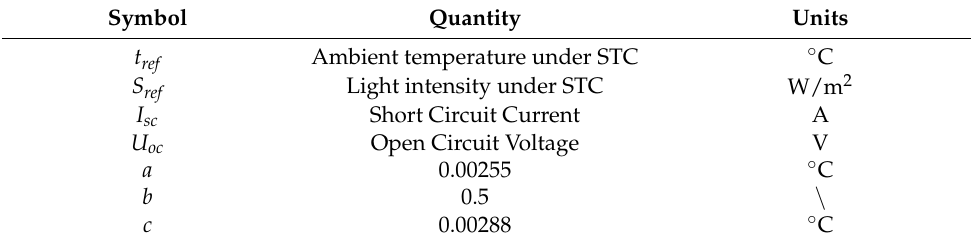
Table 1. Explanation of Symbols